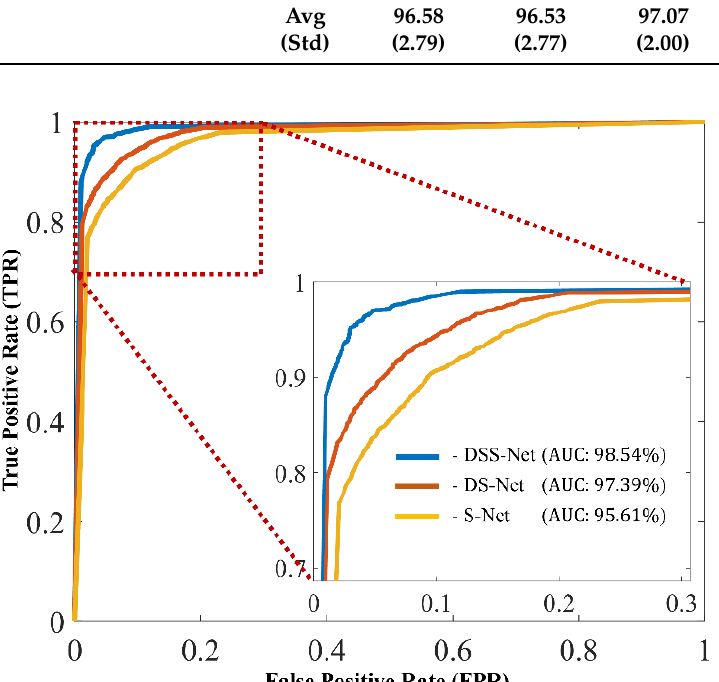
Figure 5. Comparative ROC plots of DSS-Net (best model), DS-Net (second-best model), and S-Net (baseline model). These plots show the trade-off between the average false-positive rate (FPR) and true-positive rate (TPR) of each model according to different thresholds.